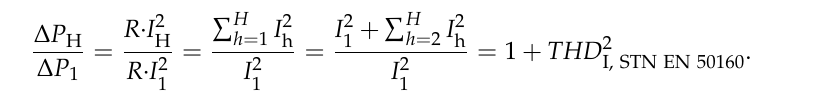
95/15: ( a ) the length of 5 km; ( b ) the length of 30 km. 95 / 15: ( a ) the length of 5 km; ( b ) the length of 30